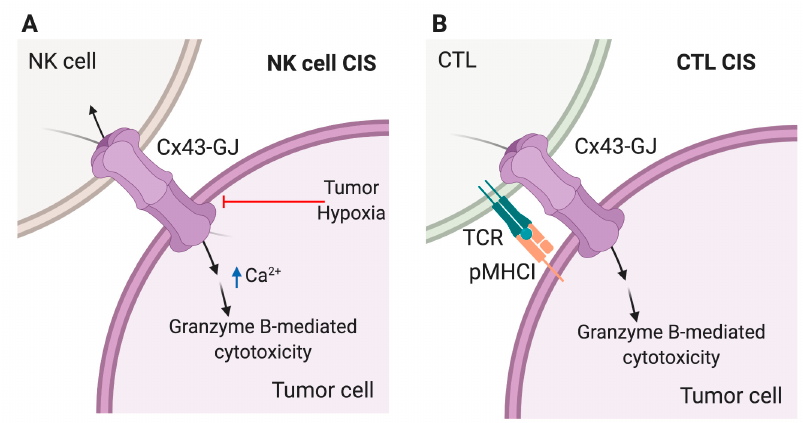
Figure 3. Cx43-mediated signaling at the cytotoxic immunological synapses (CIS). Cx43 gap junction (Cx43-GJ) channels polarize to the CIS formed during NK cell (A) and CTL (B) mediated killing of tumor cells. ( A ) NK cells and target tumor cells form bidirectional GJ coupling (represented by the two arrows crossing the Cx43-GJ) that allow, via an unknown mechanism, an efficient Ca 2+ influx into the target cells, contributing to granzyme B activity and apoptosis of tumor cells (indicated by the arrow). Hypoxia induces the degradation of Cx43-GJ and renders hypoxic tumor cells resistant to NK cell-mediated cytotoxicity (indicated by the T-bar red arrow). ( B ) Cx43-GJ formation and coupling (indicated by the arrow crossing the Cx43-GJ) is necessary for an efficient antigen-dependent CTL-mediated tumor cell lysis (represented by the arrow).